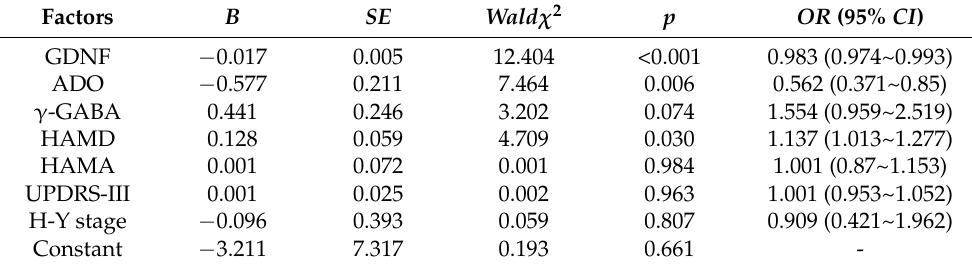
Table 6. Logistic regression of sleep disorders in PD patients.